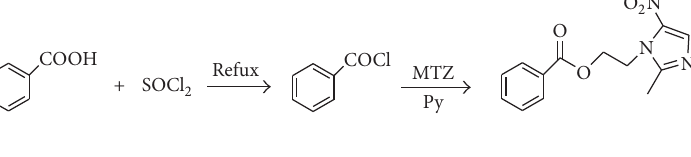
S 1: e conventional routes.